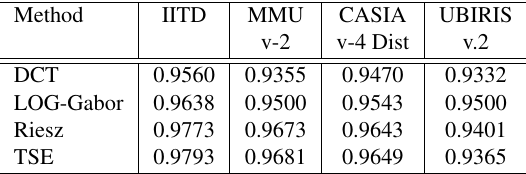
Table 2. RI obtained by using Riesz filter with two different distance measures HD and WMHD, on all the databases.